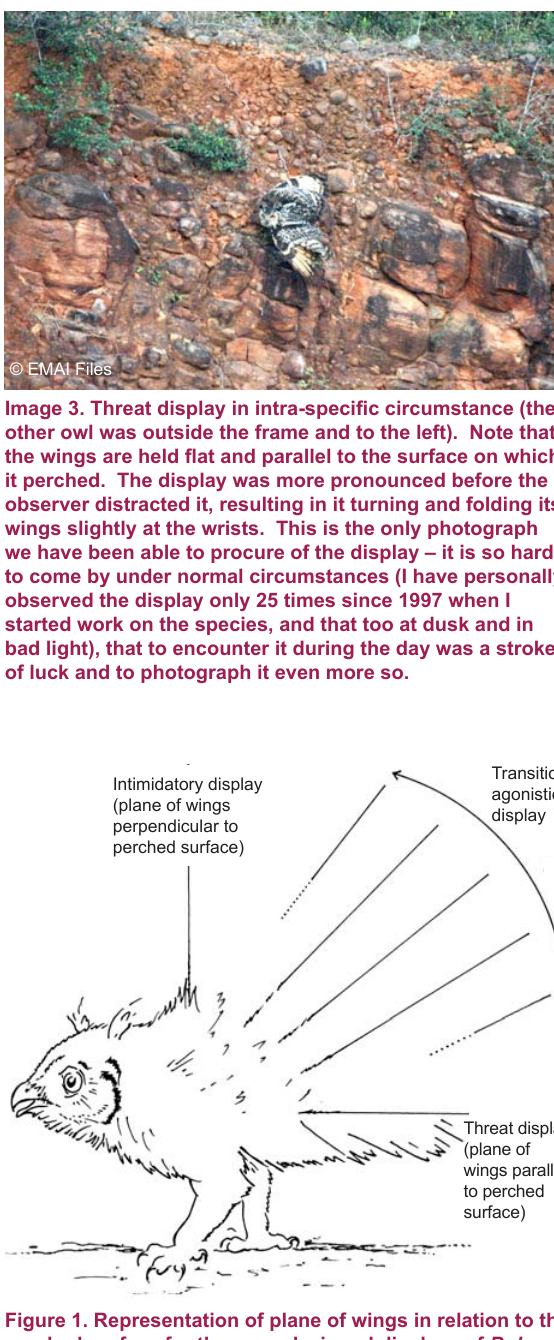
Figure 1. Representation of plane of wings in relation to the perched surface for the spread-winged displays of Bubo